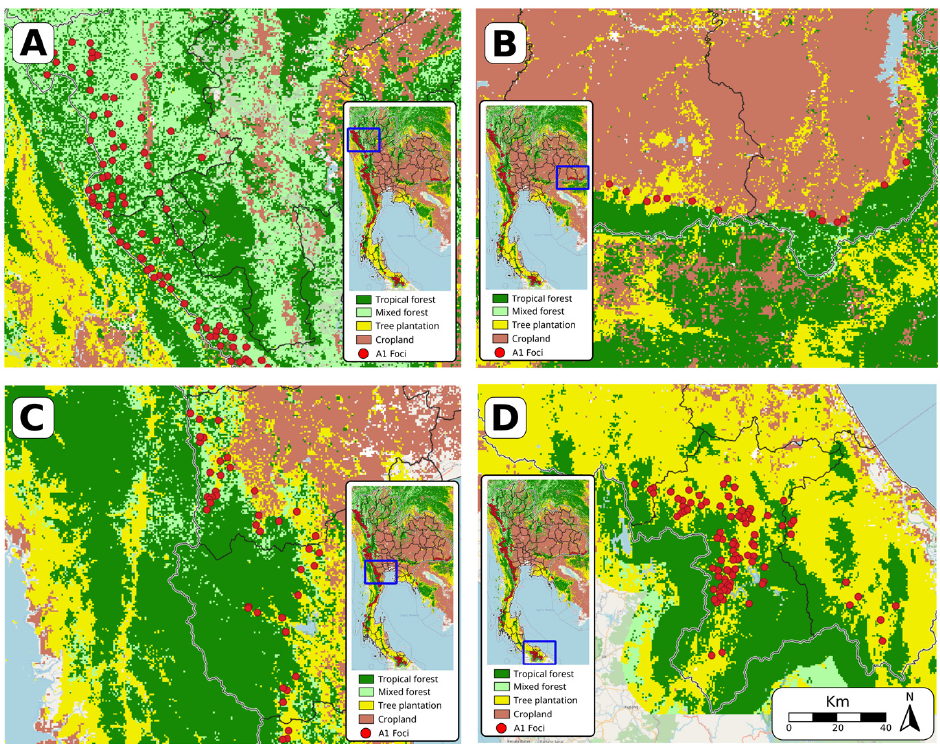
Figure 4. Areas covered by forest, plantation, and cropland around A1 foci in northwestern ( A ), eastern ( B ), central ( C ), and southern ( D ) Thailand.